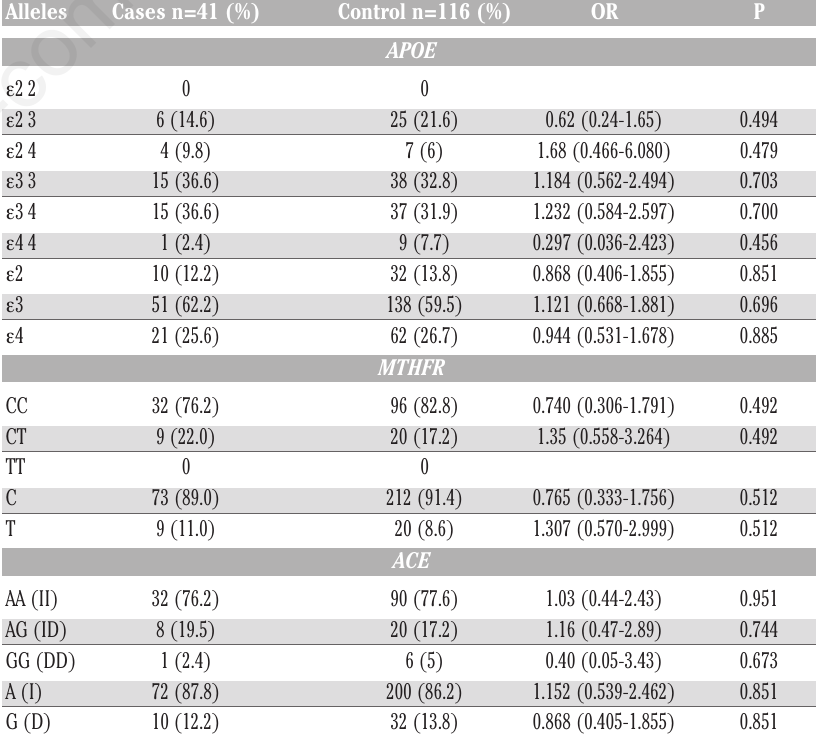
Table 1. Genotypes and alleles of stroke patients and